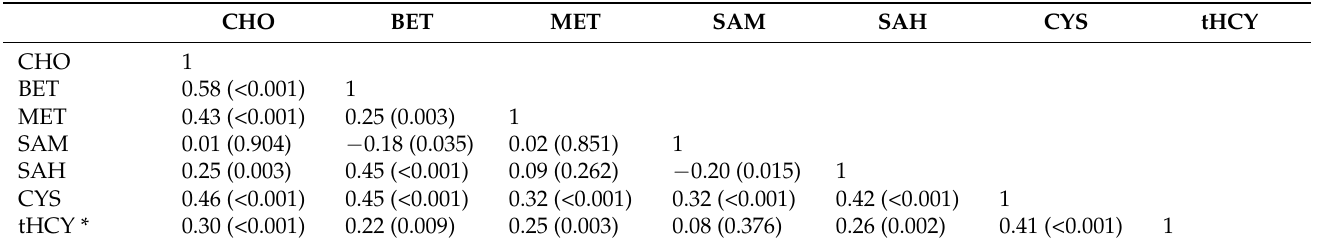
Table 2. One-carbon metabolite correlations in breast milk